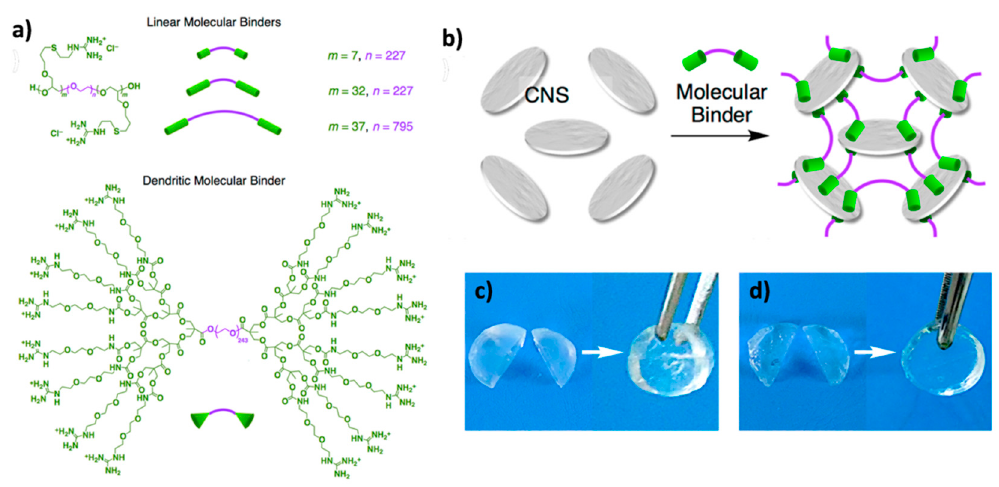
Figure 26. ( a ) Linear and dendritic molecular binders; ( b ) the addition of linear dendritic binder to exfoliated clay nanosheets for hydrogel formation. Self-repairing abilities of hydrogels formed by linear ( c ) and dendritic ( d ) molecular binders. Adapted with permission from [60], Copyright © 2013 American Chemical Society.